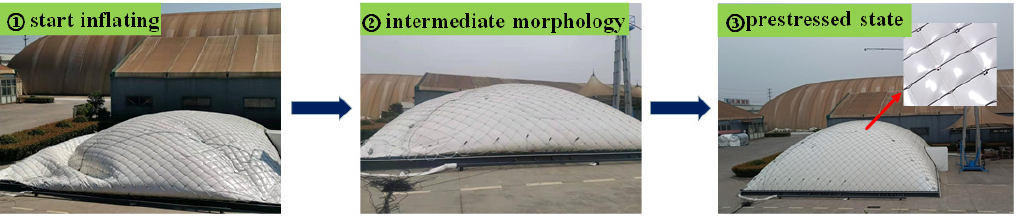
Figure 20. The process of inflating.